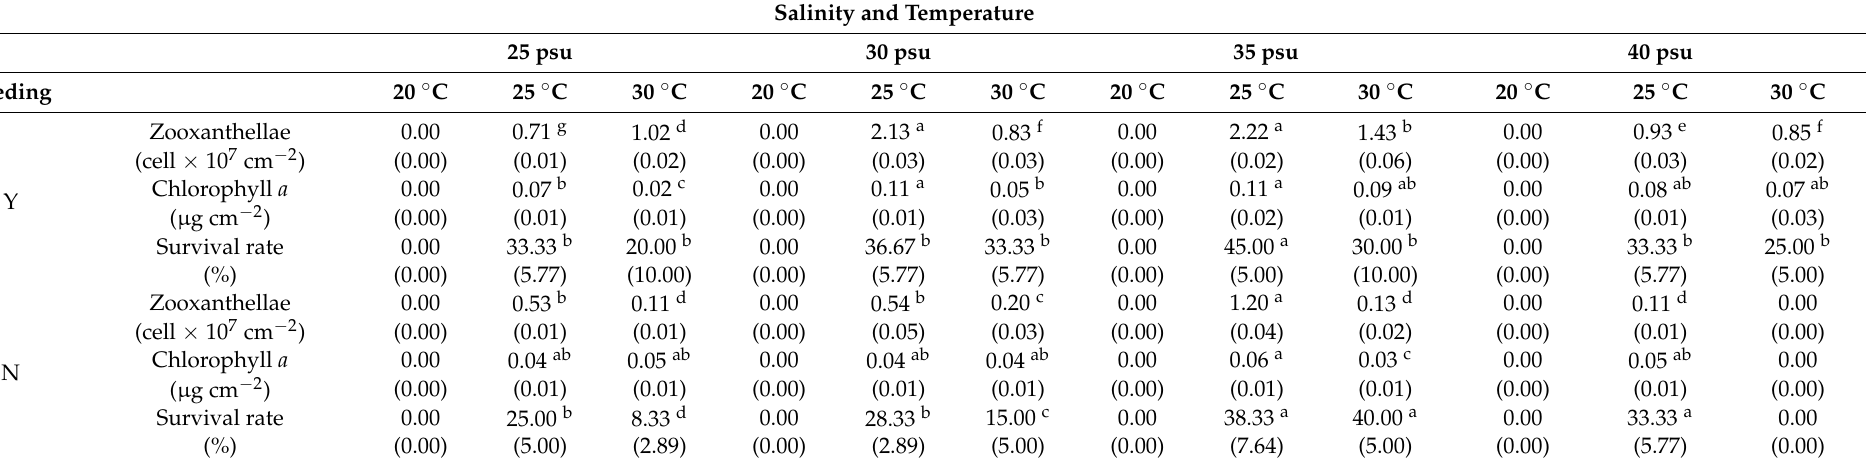
Table 5. The effect of feeding on Briareum violacea larval zooxanthellae, chlorophyll a and survival during temperature and salinity